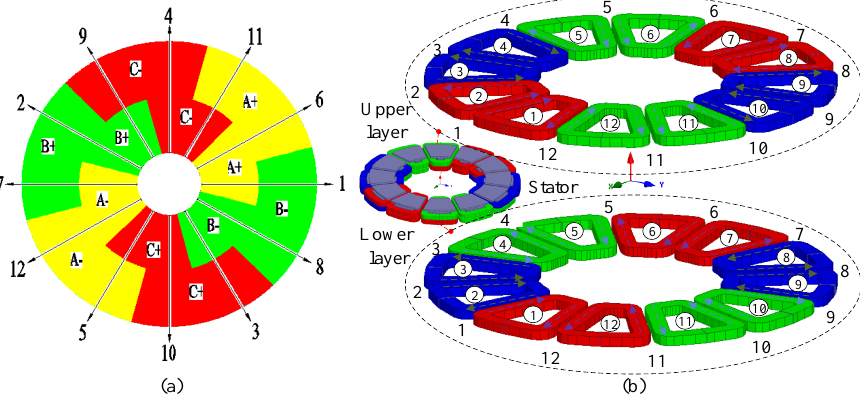
Figure 6. TP-FL winding with 12-slot/10-pole combination. ( a ) Star graph, ( b ) winding layout. Phase currents of a TP-FL winding can refer to the first groups of DTP-DL winding in (1). The winding MMF is analyzed with the winding function method. Winding functions N A (θ), N B (θ), N C (θ) are expressed as Fourier series in (5). Their corresponding curves of three-phase TP-FL windings are given in Figure 7. We can see that each phase includes four coils in Figure 7.